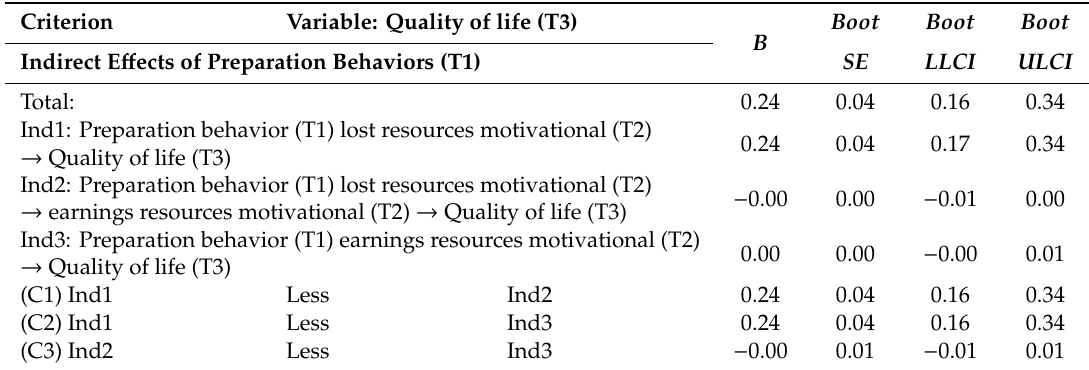
Table 4. Comparison of the indirect e ff ects of preparation behaviors (T1) through motivational resource losses (T2) and gains (T2) in the prediction of quality of life